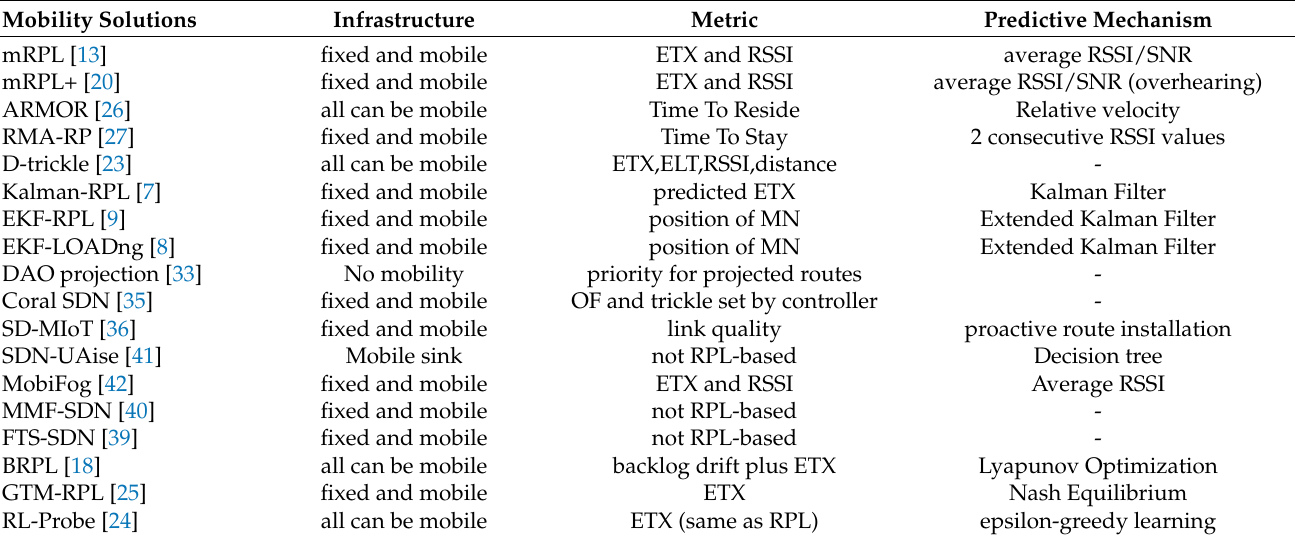
Table 1. Mobility management extensions for